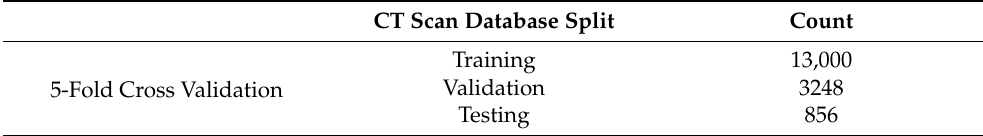
Table 1. Five-fold cross validation and testing CT scan image distribution.